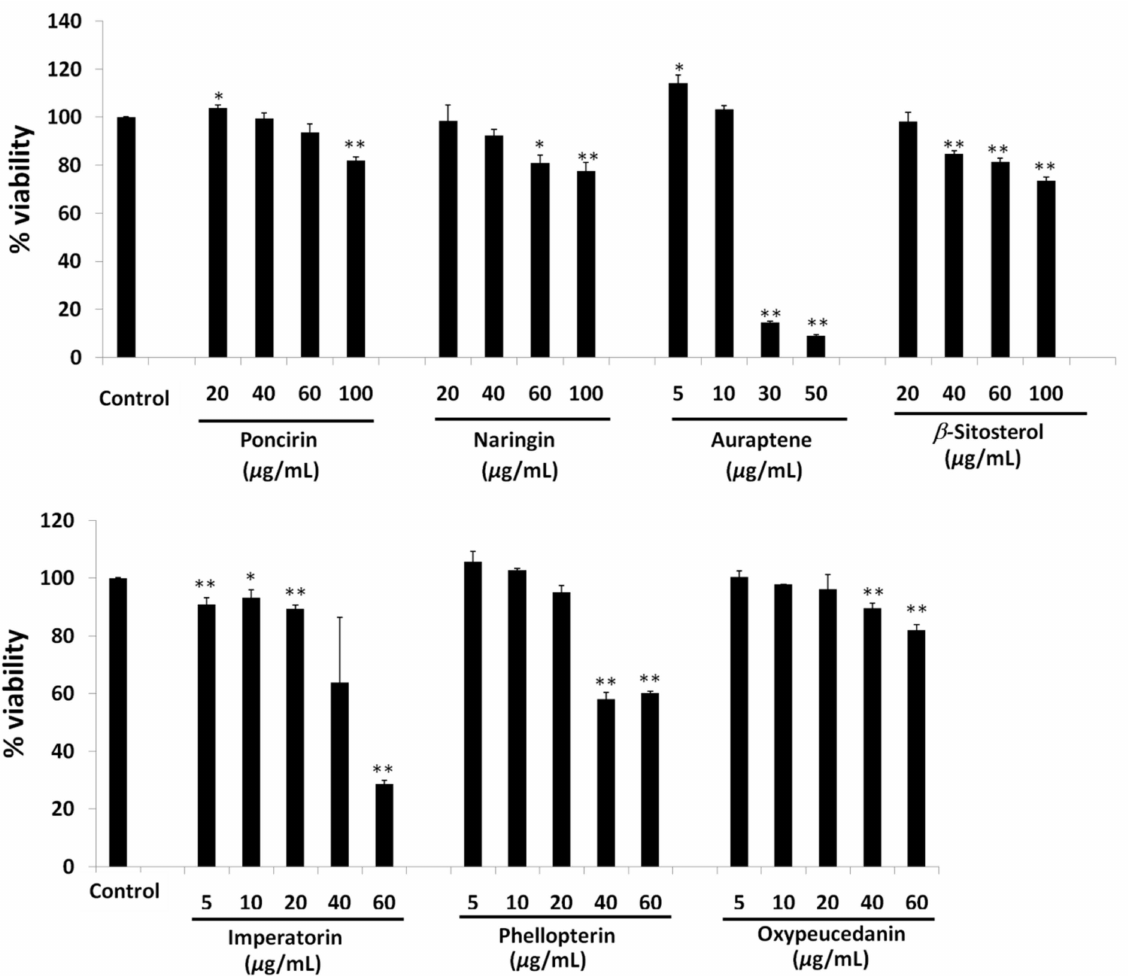
Figure 4. Cell viability of 3T3-L1 cell on treatment with poncirin, naringin, auraptene, β -sitosterol, imperatorin, phellopterin and oxypeucedanin isolated from Ponciri Fructus. Each set of data repre- sents mean of triplicate experiment ± standard deviation. Significant difference between the groups was calculated using two-tailed Student’s t -test. * p < 0.05 vs. control, ** p < 0.01 vs. control are used to represent significant difference in toxicity of the extract sample compared to non-treated control